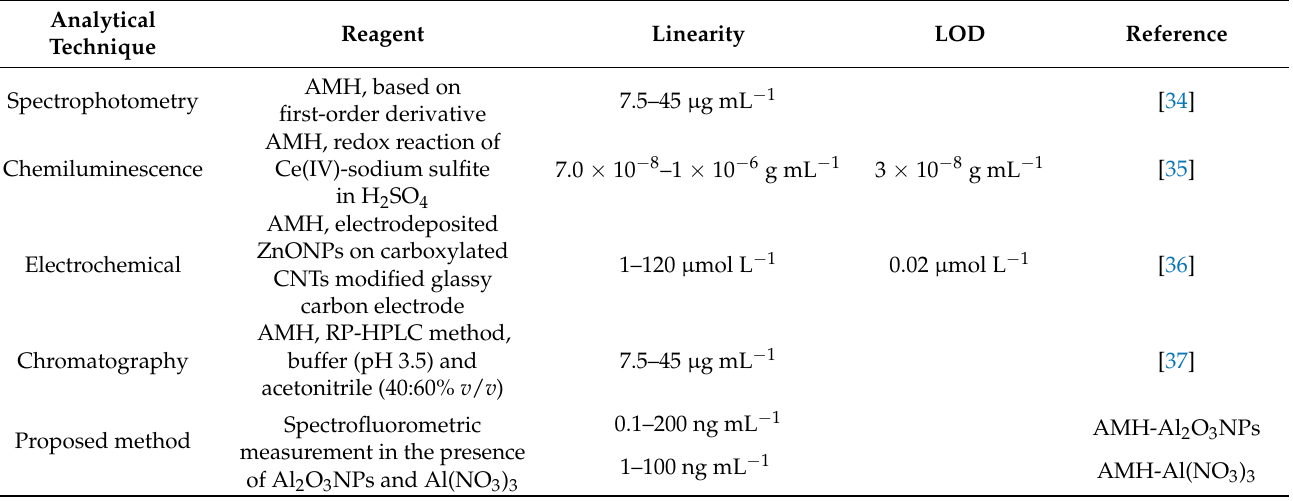
Table 7. A comparison between the current results from the assay of AMH applying the suggested spectrofluorometric Al 2 O 3 NPs-SDS and AMH-Al(NO 3 ) 3 -SDS spectrofluorometric systems and the previously reported analytical